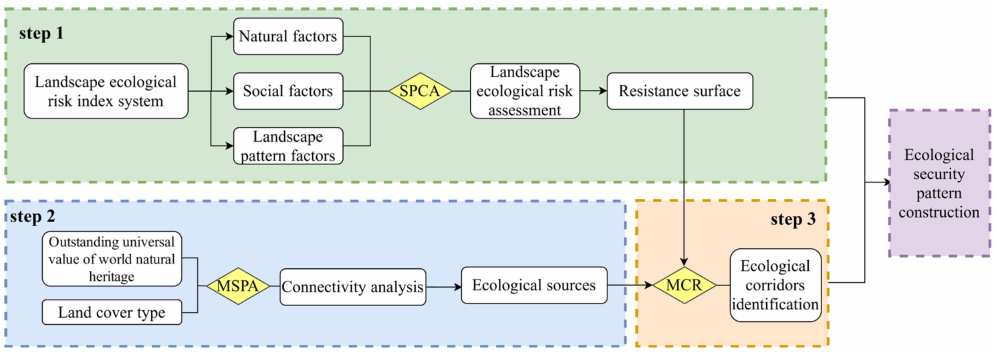
Figure 3. The framework of the research.